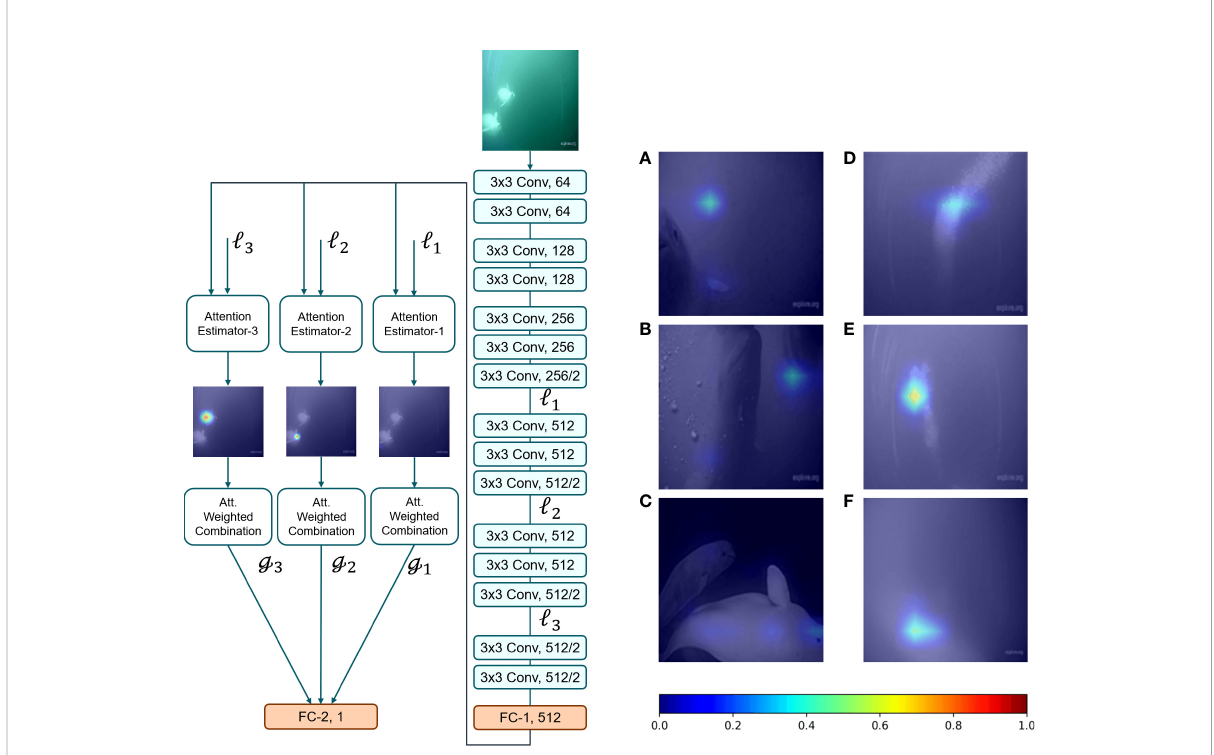
FIGURE 3 Left: The architecture of VGG-16 with the attention module. Right: Panels (A – C) show correctly classi fi ed images that contain beluga and (D – F) show incorrectly classi fi ed images. The colour bar de fi nes regions with varying attention values, where the blue and red extremes signify lower and higher attention values, respectively.